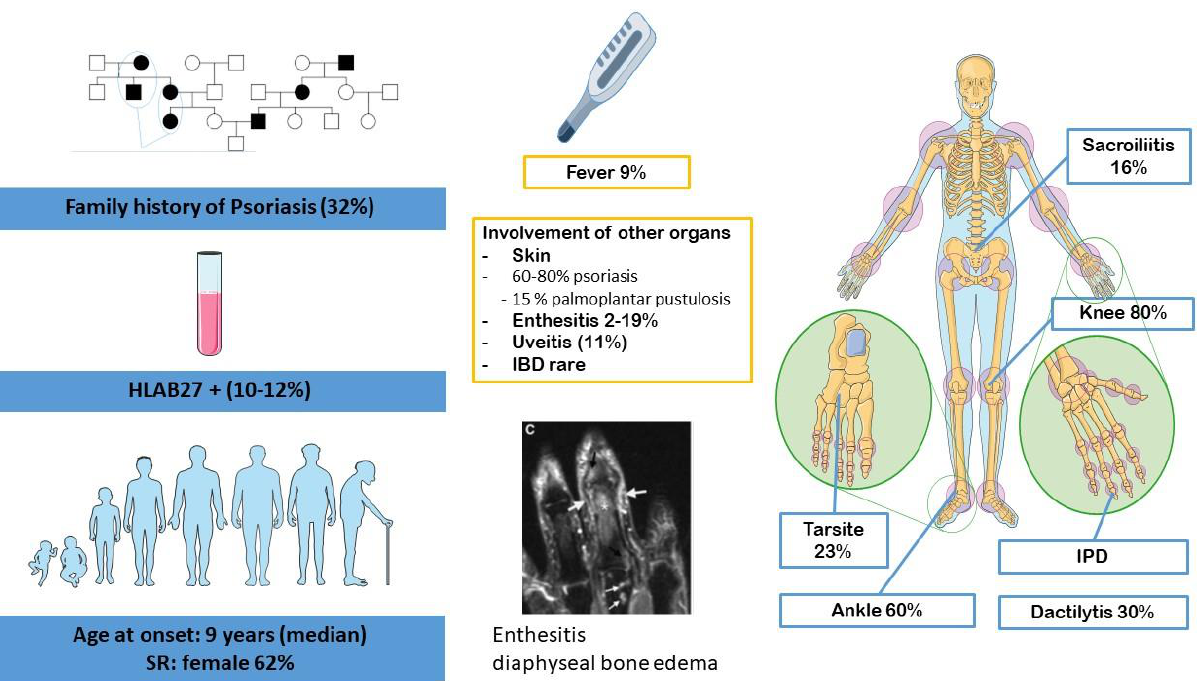
Figure 3. Clinical characteristics of JPsA. JPsA: juvenile psoriatic arthritis.